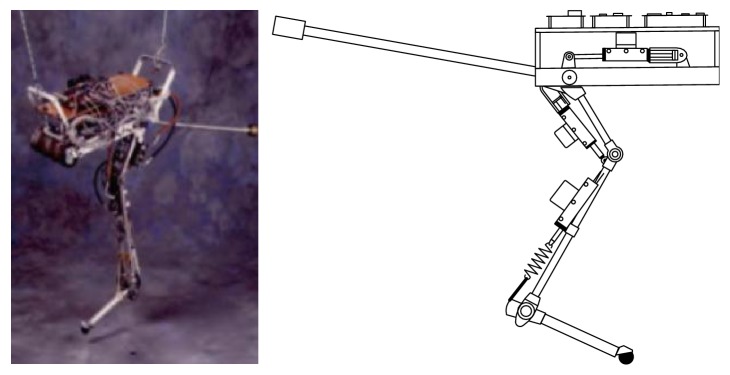
Jumping robot Uniroo [14, 35].